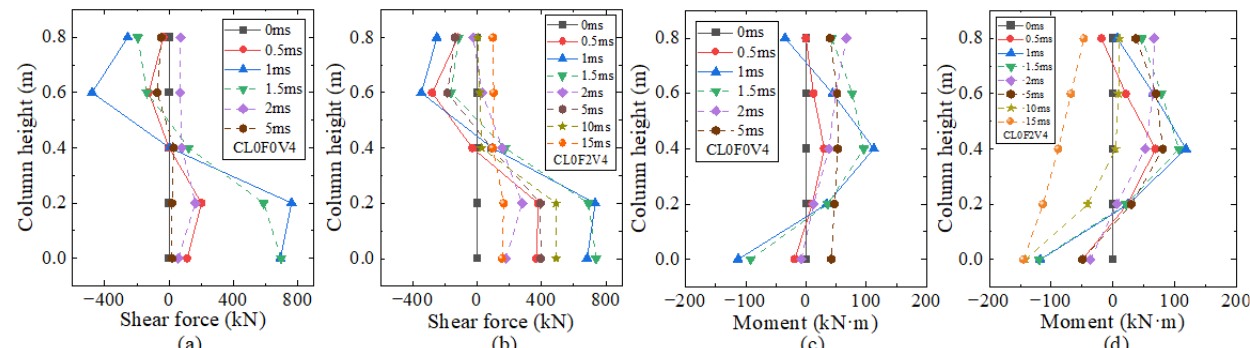
Figure 14. Distribution along the column height: ( a ) shear force of column CL0F0V4; ( b ) shear force of column CL0F2V4; ( c ) bending moment of column CL0F0V4; ( d ) bending moment of column CL0F2V4.